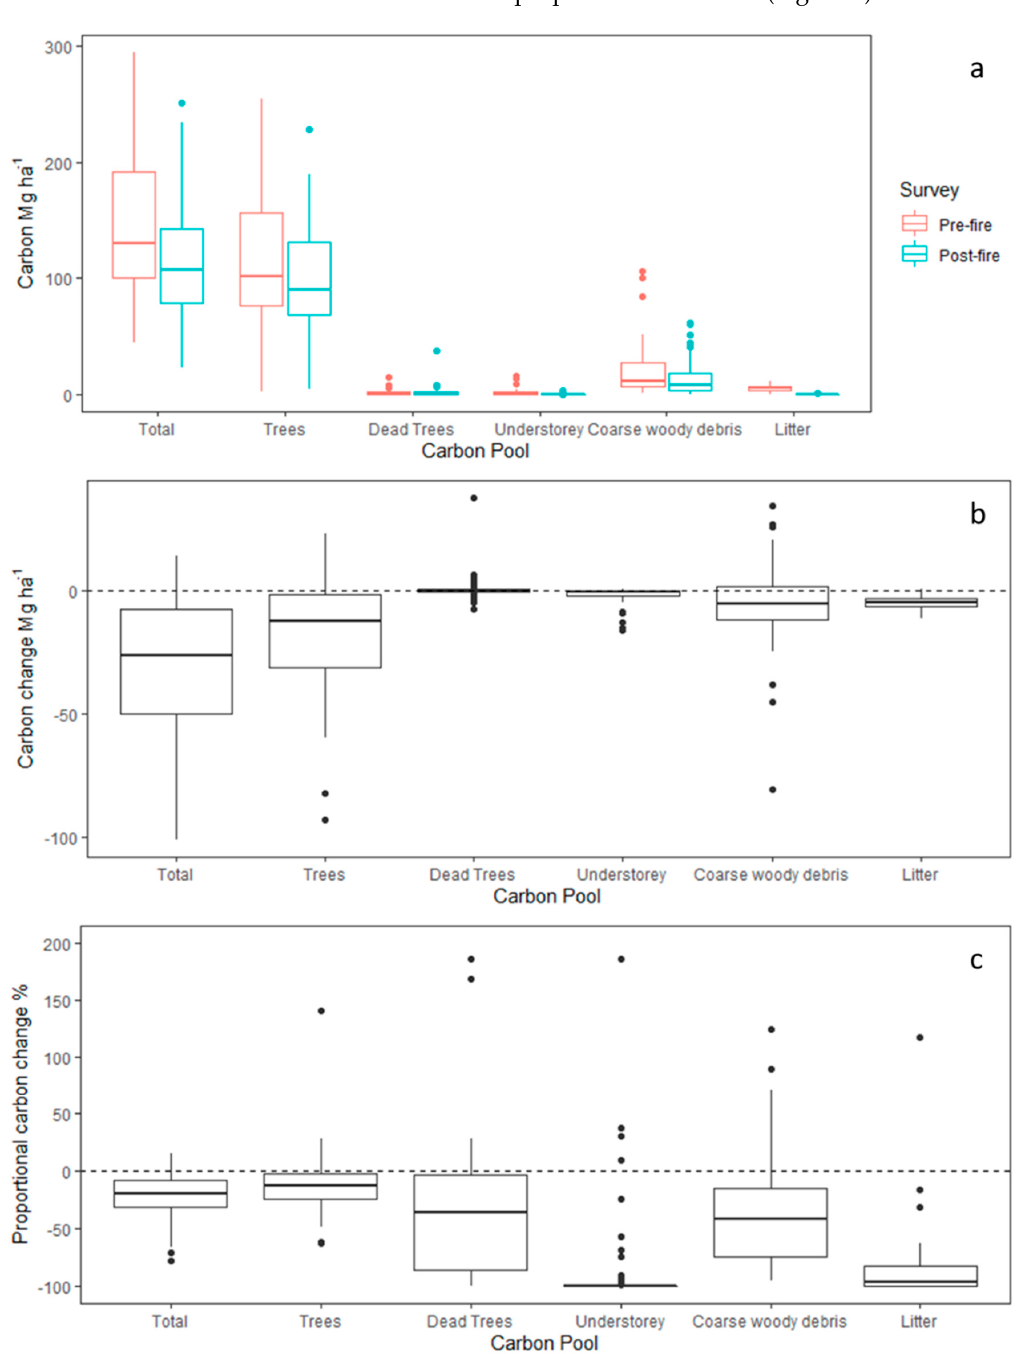
Figure 2. Distribution of measured above ground carbon stocks from the pre- and post-fire surveys ( a ), the change in above ground carbon stocks between the two surveys ( b ) and the proportional change in above ground carbon stocks between the two surveys in each carbon pool ( c ). Distributions are represented by the median (centre line of the box), the 25th and 75th percentile (lower and upper limits of the box respectively), the 2.5th and 97.5th percentiles (lower and upper limits of the whiskers respectively) and outliers (individual points). Nine outliers from the dead tree pool and seven outliers from the coarse woody debris pool were removed as they exceeded 200% and made visualization of the remaining data